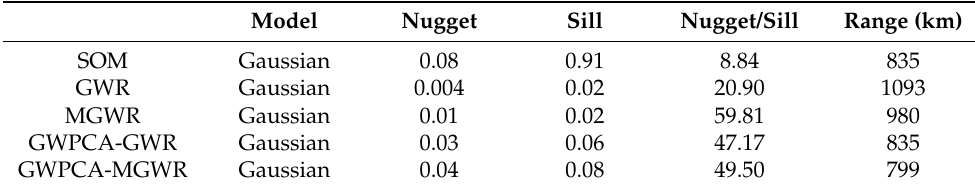
Table 3. Parameters of variograms for SOM and regression